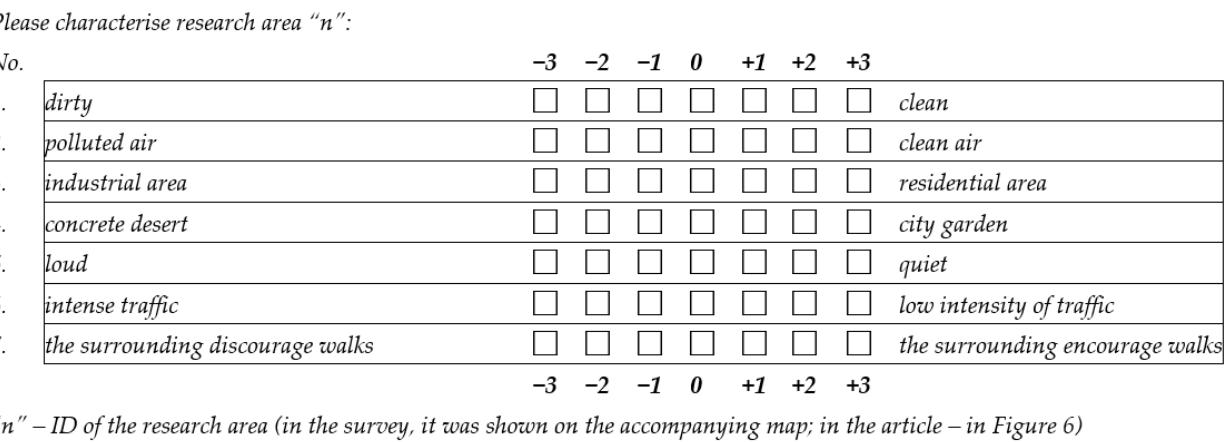
Figure 2. Semantic differential used to evaluate the research areas.